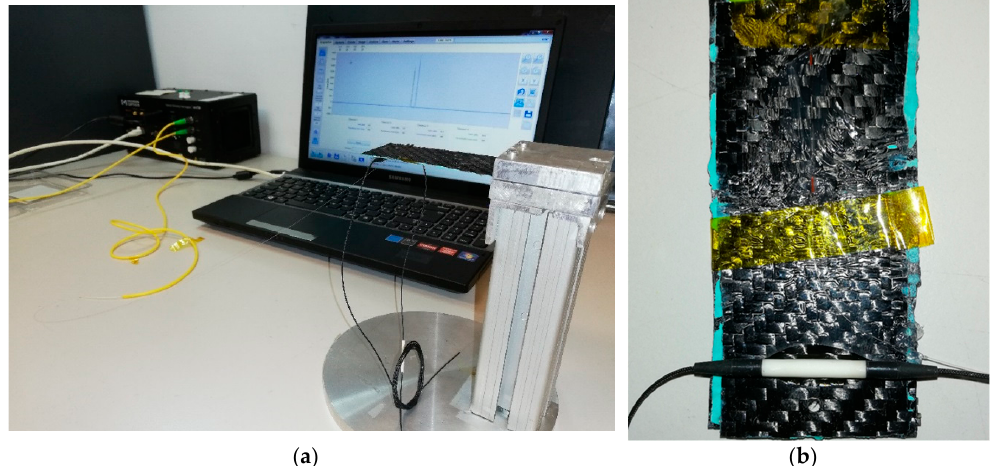
Figure 9. Experimental setup used for reproducing the SMP actuator working cycle: entire setup ( a ) and detail of the specimen ( b ). and detail of the specimen ( b